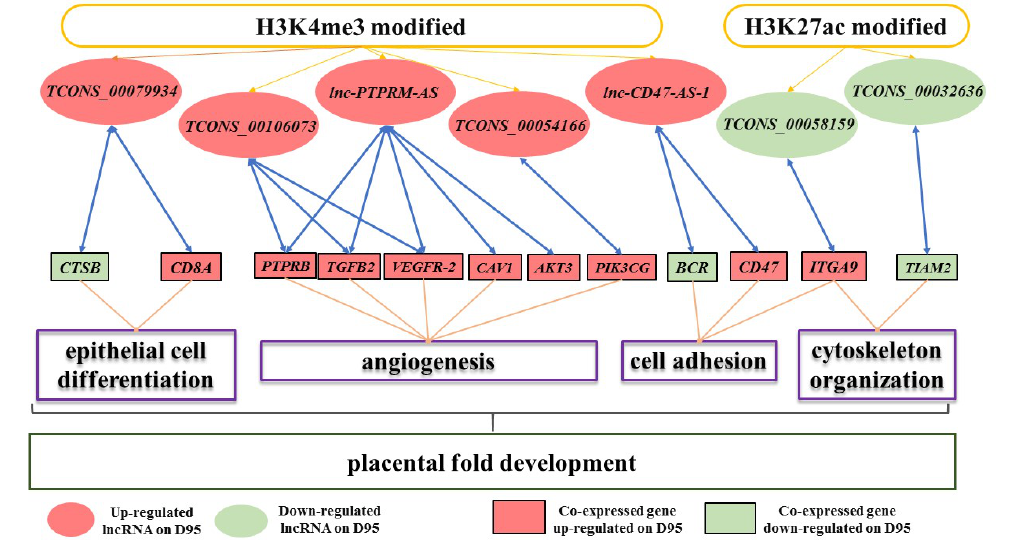
Figure 5. Schematic illustration of the potential roles of H3K4me3 / H3K27ac–lncRNA–gene pathways on porcine placental development.